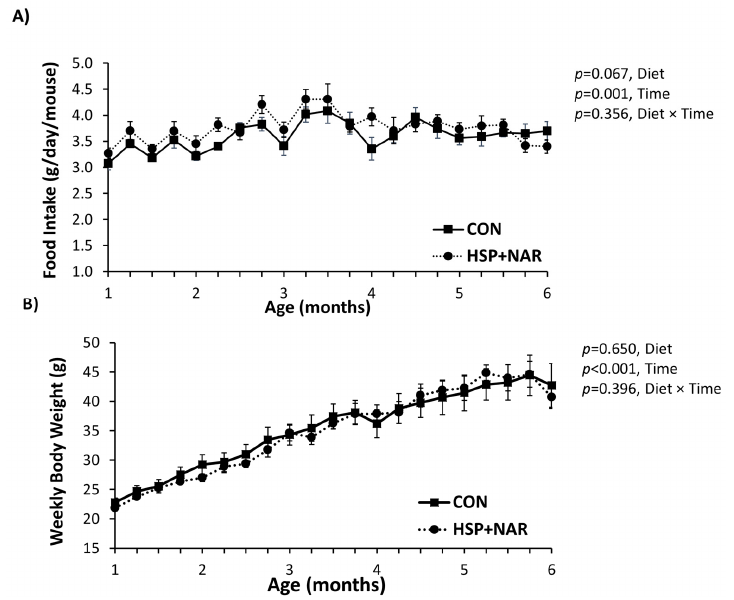
Figure 1. Mean daily food intake ( A ) and body weight ( B ) of female mice whose mothers were fed a control diet (CON) or a diet consisting of a combination of 0.5% hesperidin (HSP) and 0.25% naringin (NAR) before and during pregnancy and lactation, n = 8–9 per group. Mean ± standard error of the mean (SEM).